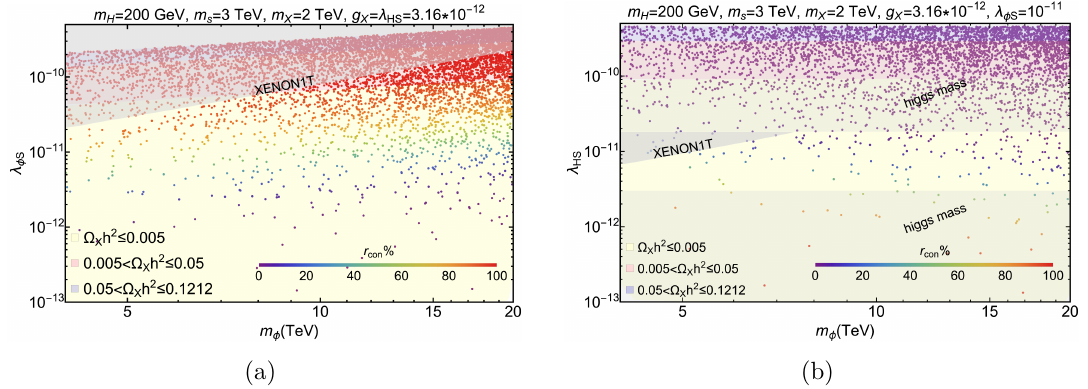
Figure 10 . Numerical scan of the under-abundant region of X relic for freeze-in bEWSB, when m s < 2 m X . Figure 10(a) and 10(b) show correlation in m φ − λ φS and m φ − λ HS planes respectively. Three different colour shades indicate different ranges of relic density (see figure inset) for fixed values of other parameters written in figure heading. The rainbow colour bar represents how much the WIMP-FIMP conversion ( φφ → XX ) is contributing in production of X by the ratio r con (see eq. (4.24)). Grey shaded areas signify the regions excluded by direct detection and Higgs mass